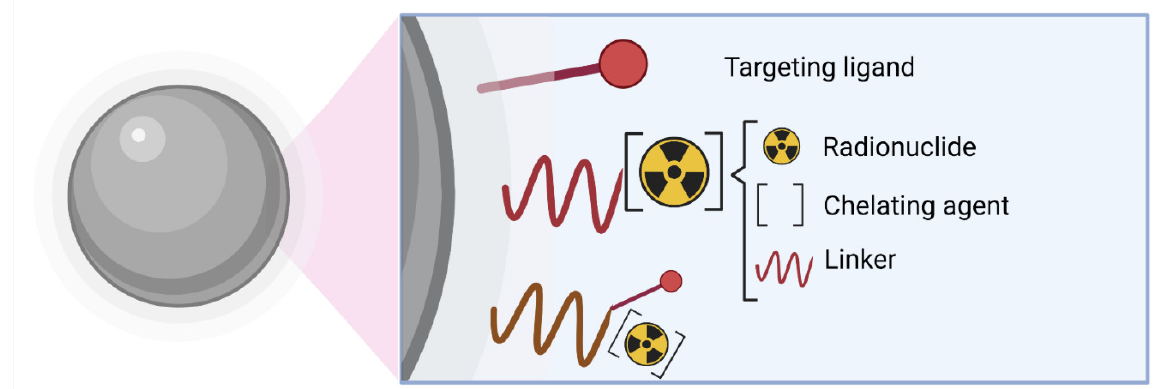
Figure 5. Main components of targeted radiolabeled nanoparticles. Radionuclides can be conjugated directly onto the nanoparticle surface, with or without a spacer.